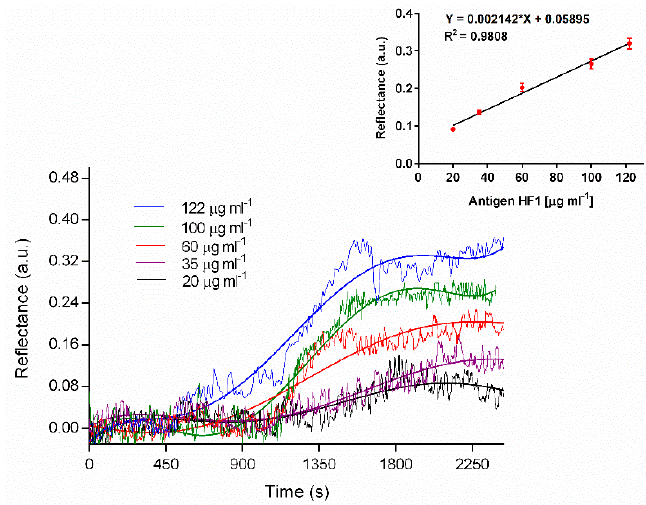
Figure 5. Real-time SPR sensograms for HF1 detection at different concentrations and calibration curves in PBS. Each point represents the mean ± SD of three replicates. Table 1. Analytical parameters of SPR based biosensors for black Sigatoka pathogen detection.